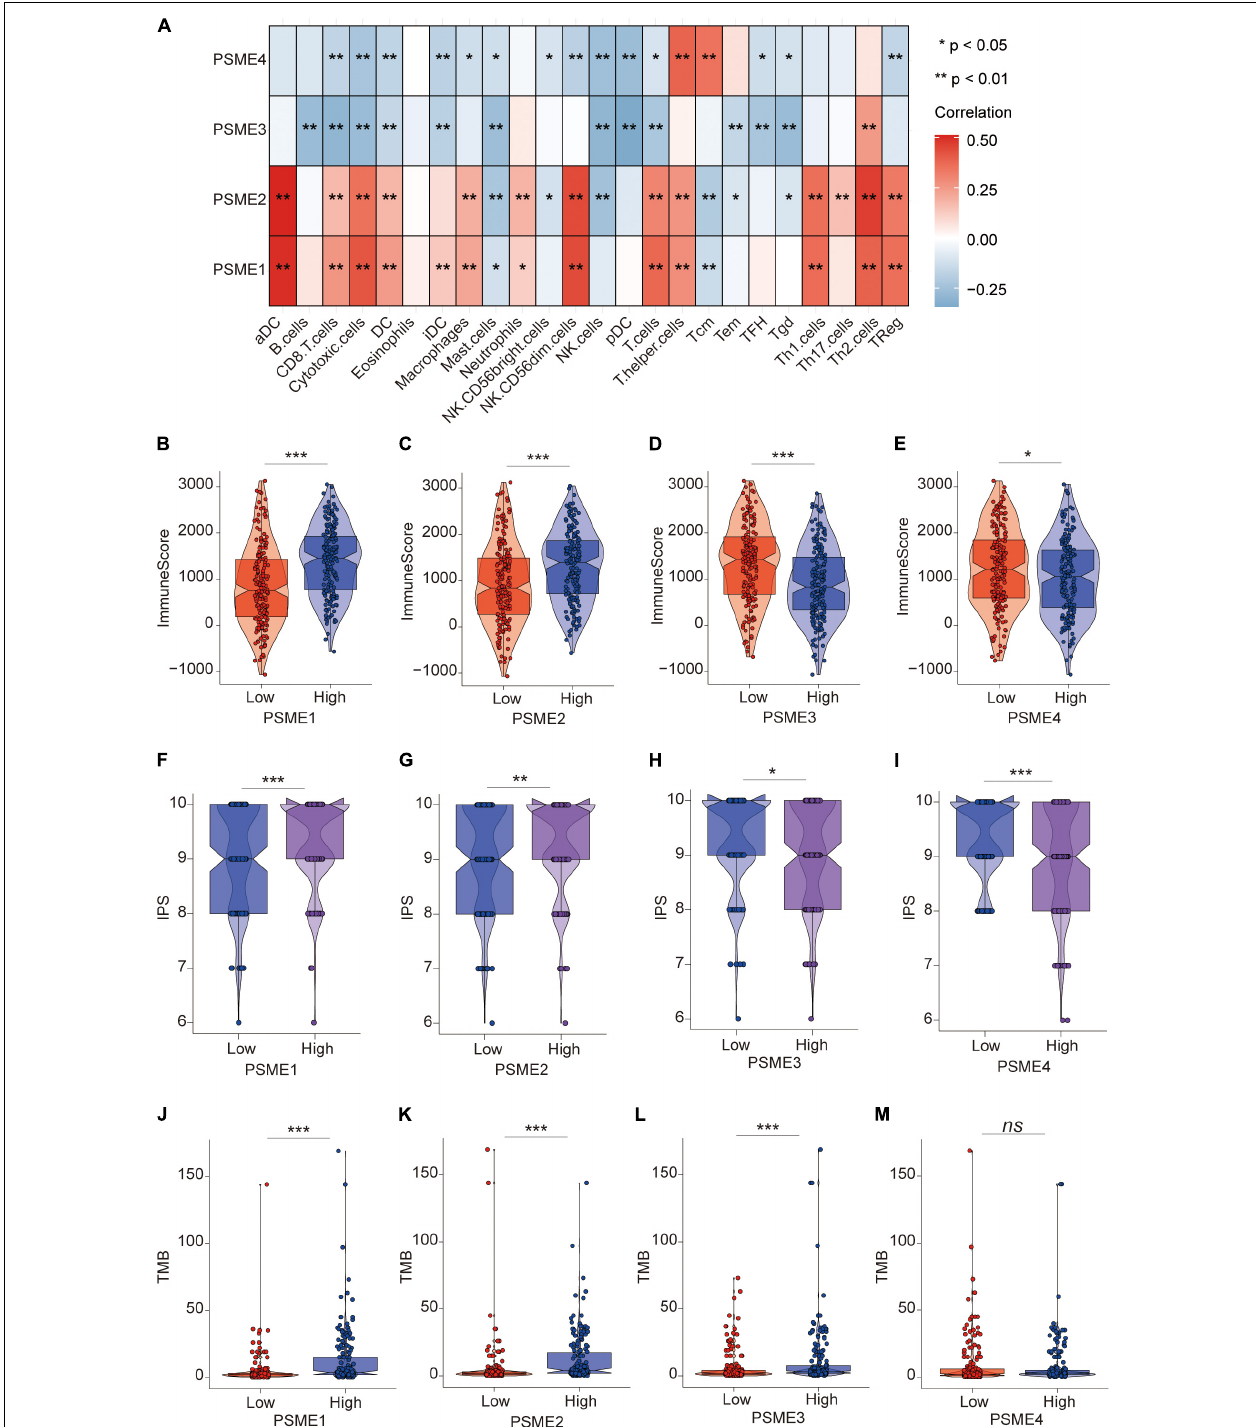
FIGURE 11 | The role of PSME genes in the prediction of immunotherapeutic benefits. (A) The correlation of the infiltration levels of immune cells and the expression of PSME genes in TCGA-STAD cohort. * p < 0.05; ** p < 0.01; *** p < 0.001; and **** p < 0.0001. (B–E) Violin plot depicted the distribution of immunescore in high and low PSME gene expression group [ (B) PSME1, (C) PSME2, (D) PSME3, and (E) PSME4]. (F–I) Violin plot depicted the distribution of IPS in high and low PSME gene expression group [ (F) PSME1, (G) PSME2, (H) PSME3, and (I) PSME4]. (J–M) Violin plot depicted the distribution of tumor mutational burden (TMB) in high and low PSME gene expression group [ (J) PSME1, (K) PSME2, (L) PSME3, and (M) PSME4].